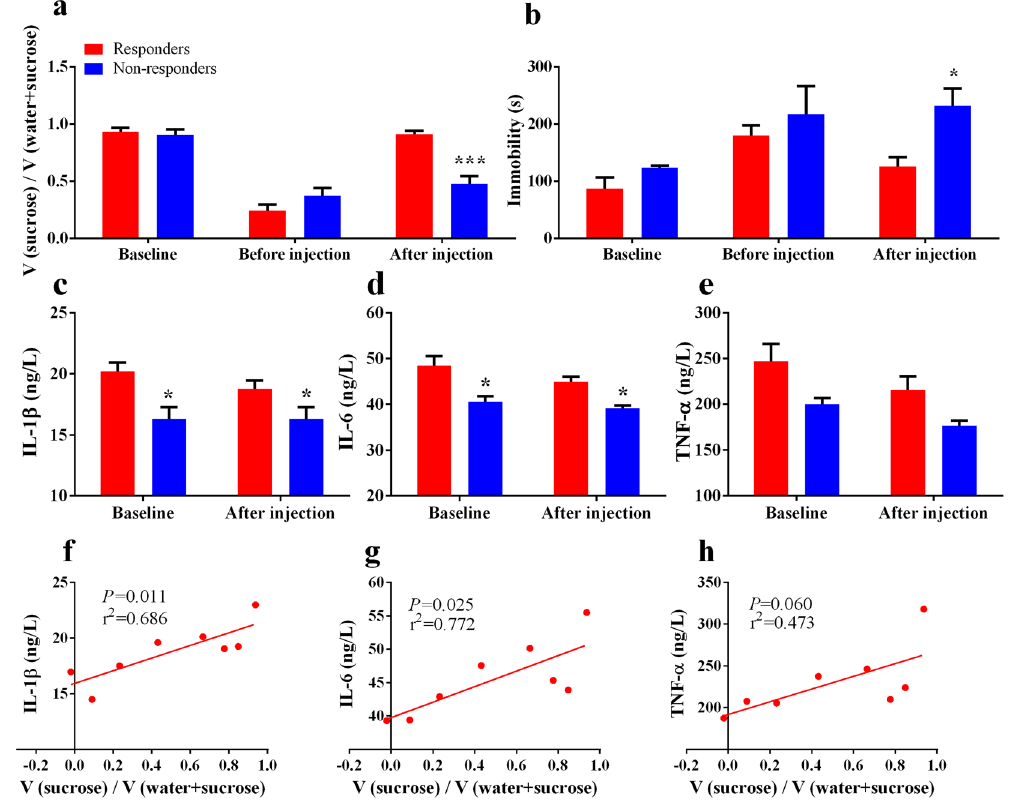
Figure 6. Serum pro-inflammatory cytokines for ketamine’s antidepressant actions. ( a , b ) Ketamine non- responder group showed decreased sucrose preference and increased immobility time after a single dose of ketamine (20 mg/kg). ( c–e ) Ketamine non-responder group showed decreased serum levels of IL-1 β and IL-6 at baseline and after ketamine injection. There was no difference of serum levels of TNF- α between ketamine- responder group and non-responder group at baseline and after ketamine injection. ( f , g ) There were positive correlations between the changes of sucrose preference after ketamine injection and serum levels of IL-1 β and IL-6 or TNF- α at baseline. ( h ) There was no correlation between the changes of sucrose preference after ketamine injection and serum levels of TNF- α at baseline. * P < 0.01 and *** P < 0.001 vs ketamine-responder